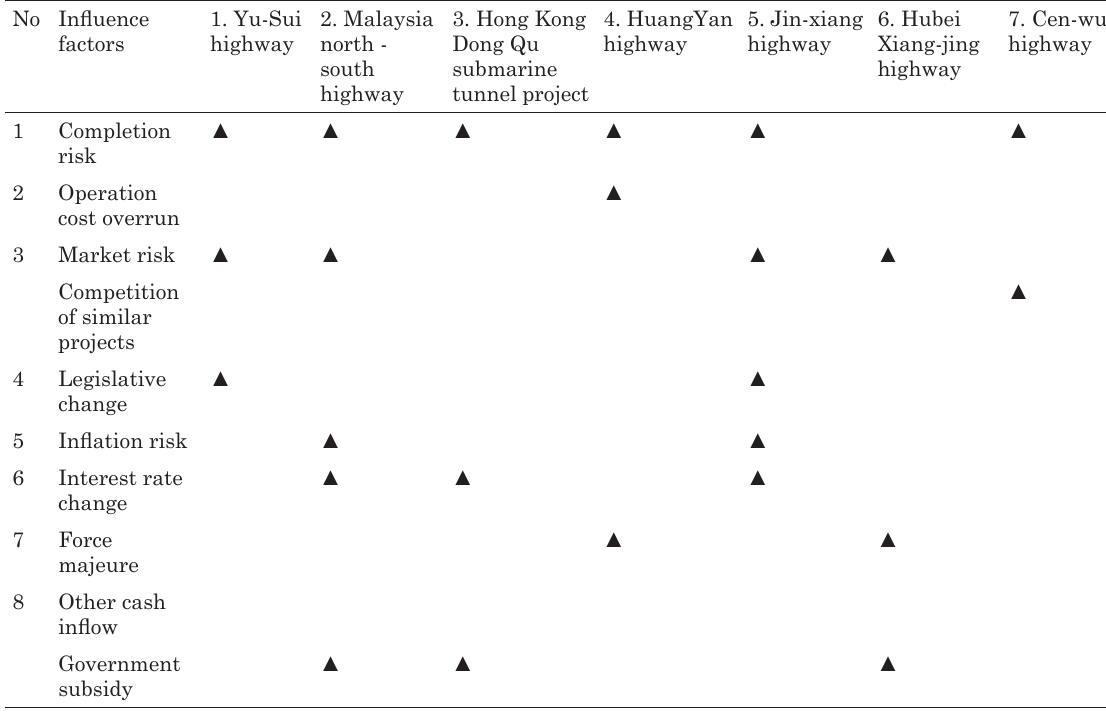
table 3. Critical risk factors influencing concession pricing of PPP highway projects no Influence